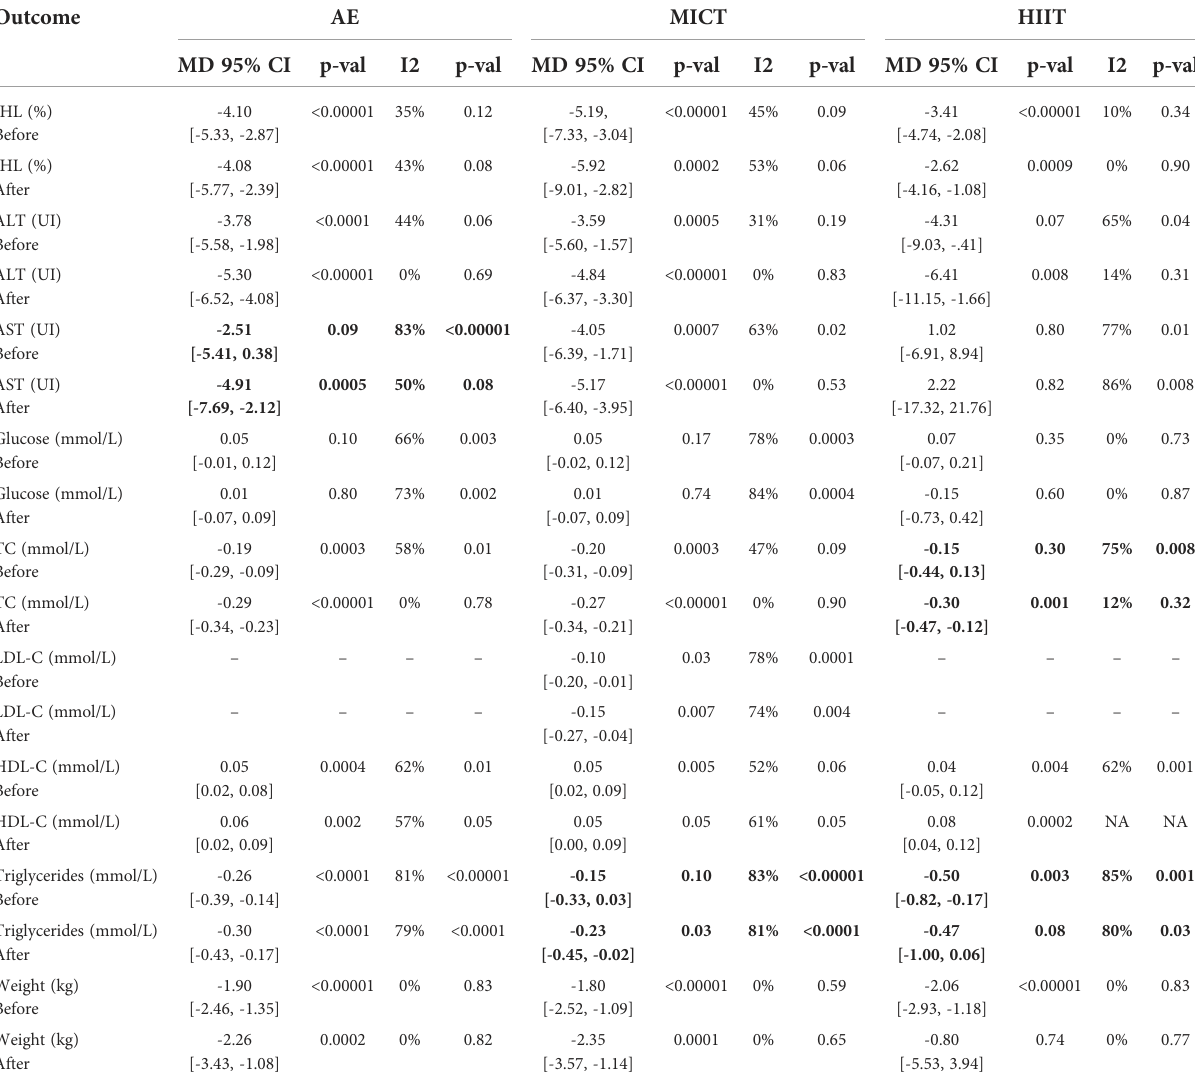
TABLE 4 Results of meta-analyses before and after sensitivity analysis including mean difference (MD), 95% CI and signi fi cance level, as well as heterogeneity (I2) and signi fi cance level per intervention type, consisting of studies with similar intervention duration excluding study by Zhang et al. and Rezende et